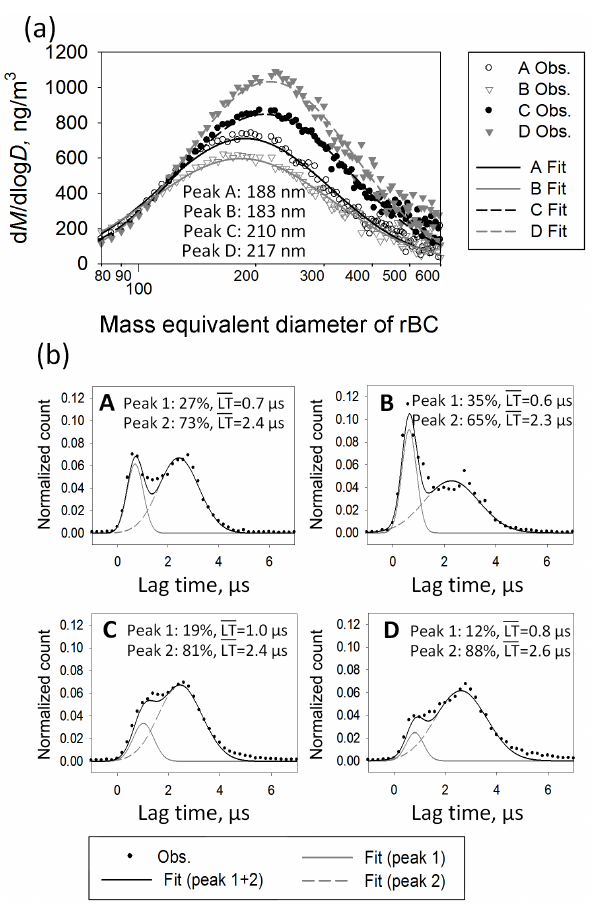
Figure 6. (a) Mass-based size distributions of rBC with log-normal best-fitting curves and (b) normalized-count distribution of lag time of the incandescent-light signal from the scattering signal for rBC with a mass equivalent diameter of 200nm, obtained using the SP2 for samples A–D with best-fit curves assuming the combination of two Gaussian functions. LT represents averaged lag time.